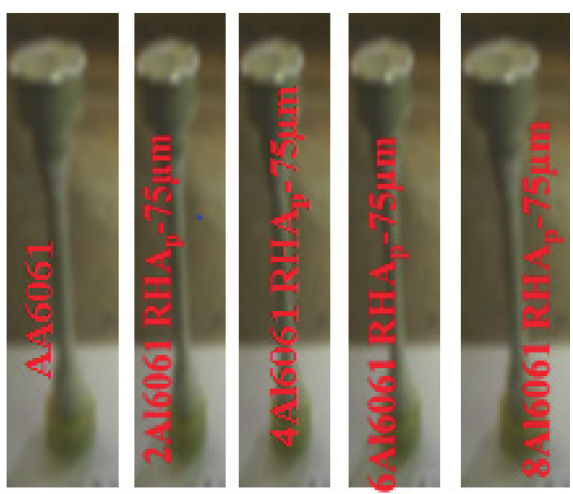
Figure 3: Developed composite material before the tensile